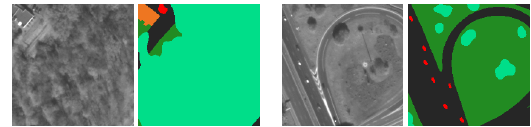
Figure 8. Sample panchromatic image patches with annotation (color coded as described in Tab.